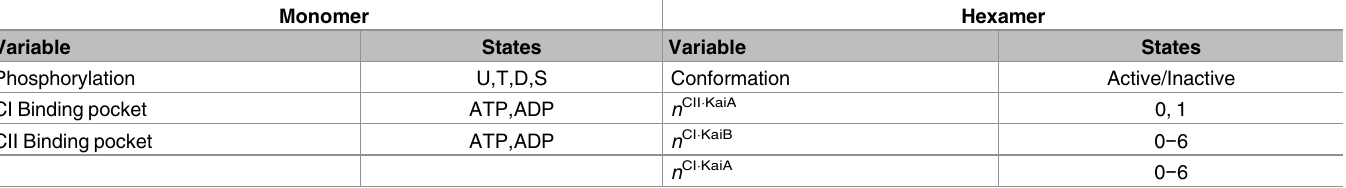
Table 1. Monomer and hexamer state variables, with possible values. Variables n CI (cid:1) KaiA and n CII (cid:1) KaiA count the number of KaiA dimers bound to the CI and CII domain,respectively,and n CI (cid:1) KaiB counts the number of KaiB monomersbound to